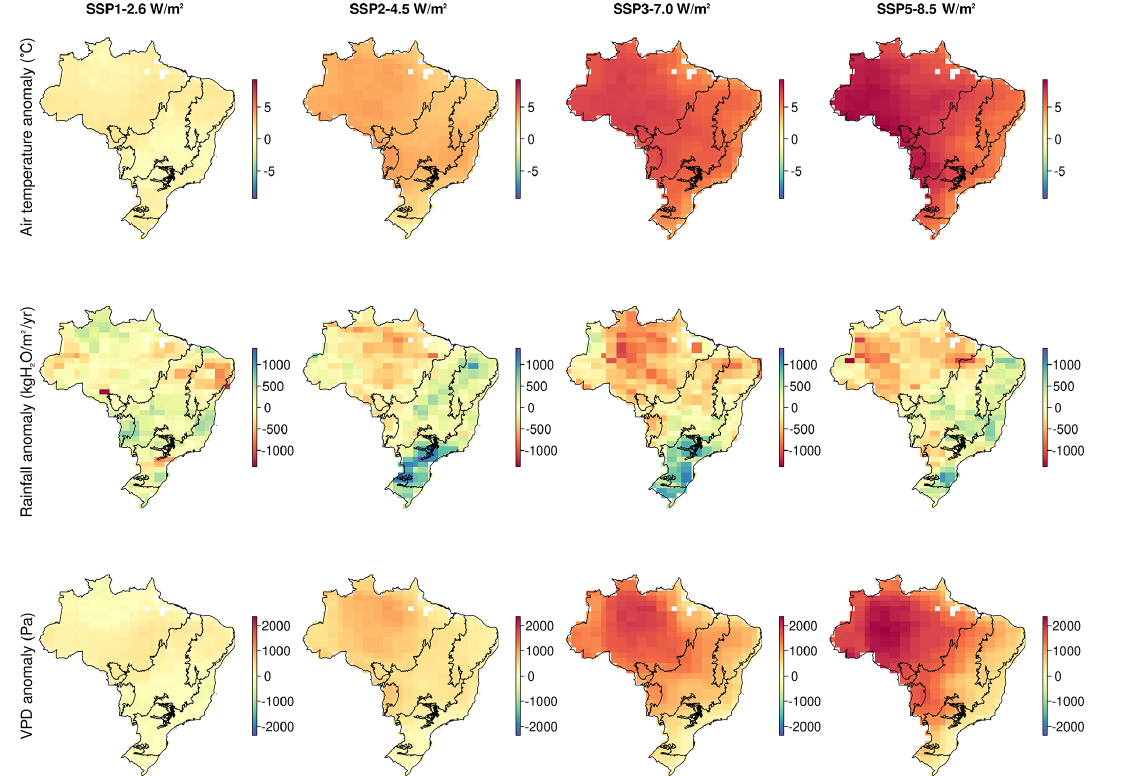
Figure A3. Maps of mean climate anomaly averaged between two 5-year periods at the beginning (2018–2022) and end (2095–2099) of the future simulations.